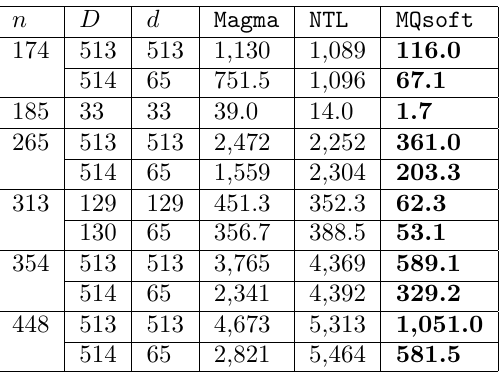
Table 14: Number of mega cycles to find the roots of a HFE polynomial. We use a Skylake processor